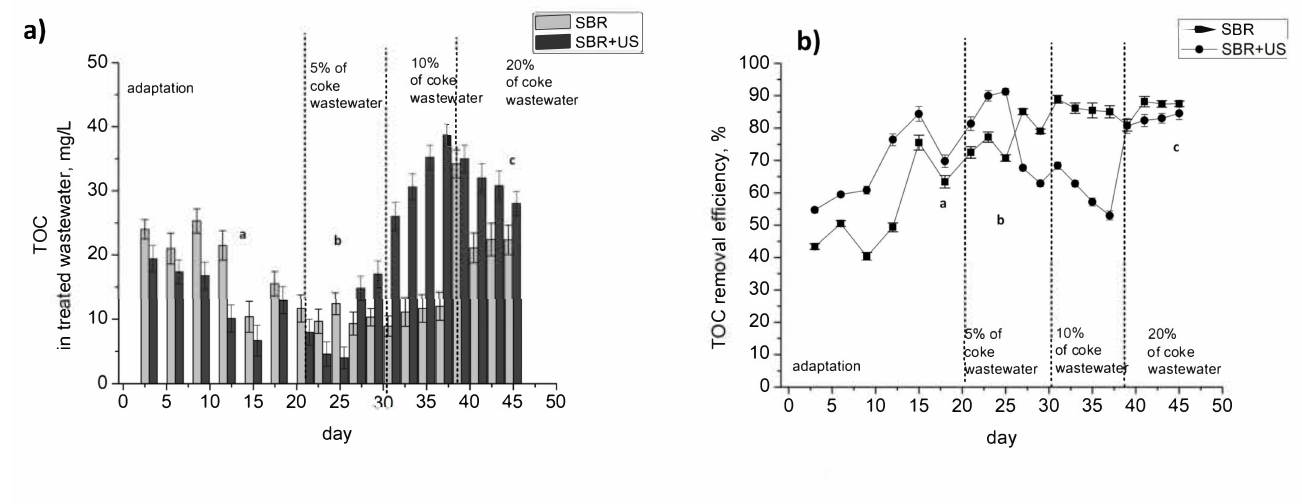
Figure 6. Total organic carbon (TOC) changes during treatment in the SBR: ( a ) concentration; ( b ) removal efficiency (Statistical group a–c).